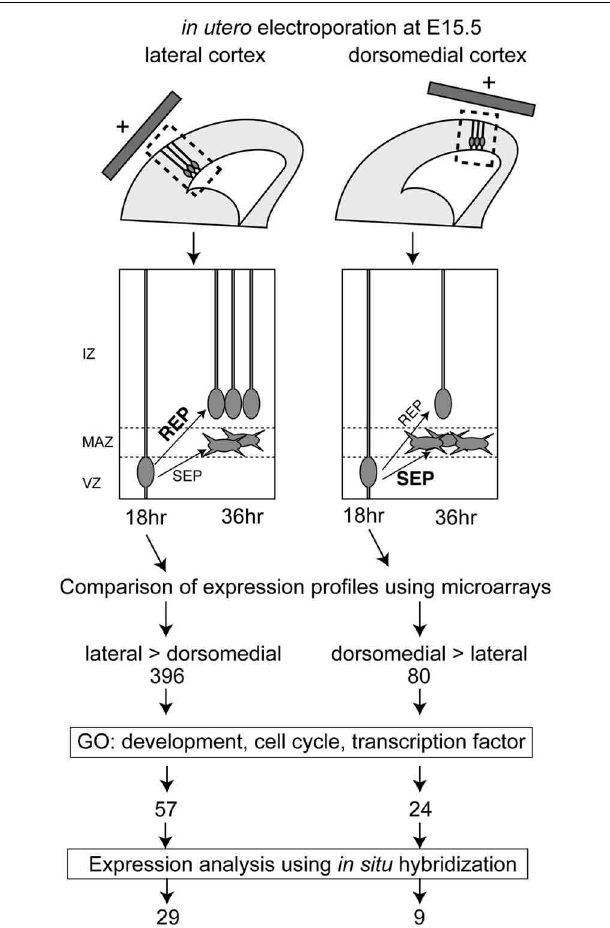
FIGURE 1 | Screening procedures for identifying genes involved in the regulation of the REP production rate and the number of genes selected in each step. The REP production rate was high in the lateral VZ, compared with the dorsomedial region. Hence, the lateral and dorsomedial VZ cells labeled using GFP and in utero electroporation at E15.5 were collected 18h after electroporation, when the cells undergo differentiation into REP or SEP. Microarray analyses identified 396 genes with a lateral-high and 80 genes with a medial-high expression pattern. The candidate genes were further selected based on gene ontology (GO) and were narrowed down to 62 candidate genes with lateral-high and 23 candidate genes with medial-high expression patterns. The expression patterns of these candidate genes were checked in the BGEM database or by performing in situ hybridization, and 29 genes with lateral-high and 9 genes with medial-high expression patterns were